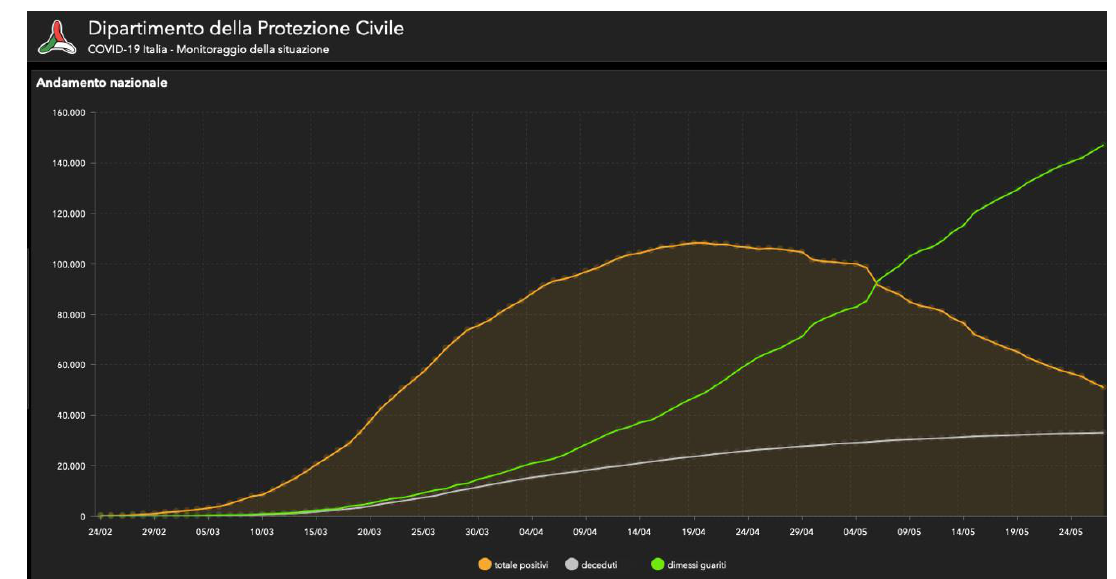
Figure 1. Graph describing the number of infections and deaths in Italy between February and May 2020. Yellow line: total positives; green line: healed and discharged; white line: dead. Official source: Ministero della Salute (Italian Ministry of Health). Last access: 28 May 2020. http://www.salute.gov.it/portale/nuovocoronavirus/dettaglioContenutiNuovoCoronavirus.jsp?lingua=italiano&id=5351&area=nuovoCoronavirus&menu=vuoto [17].